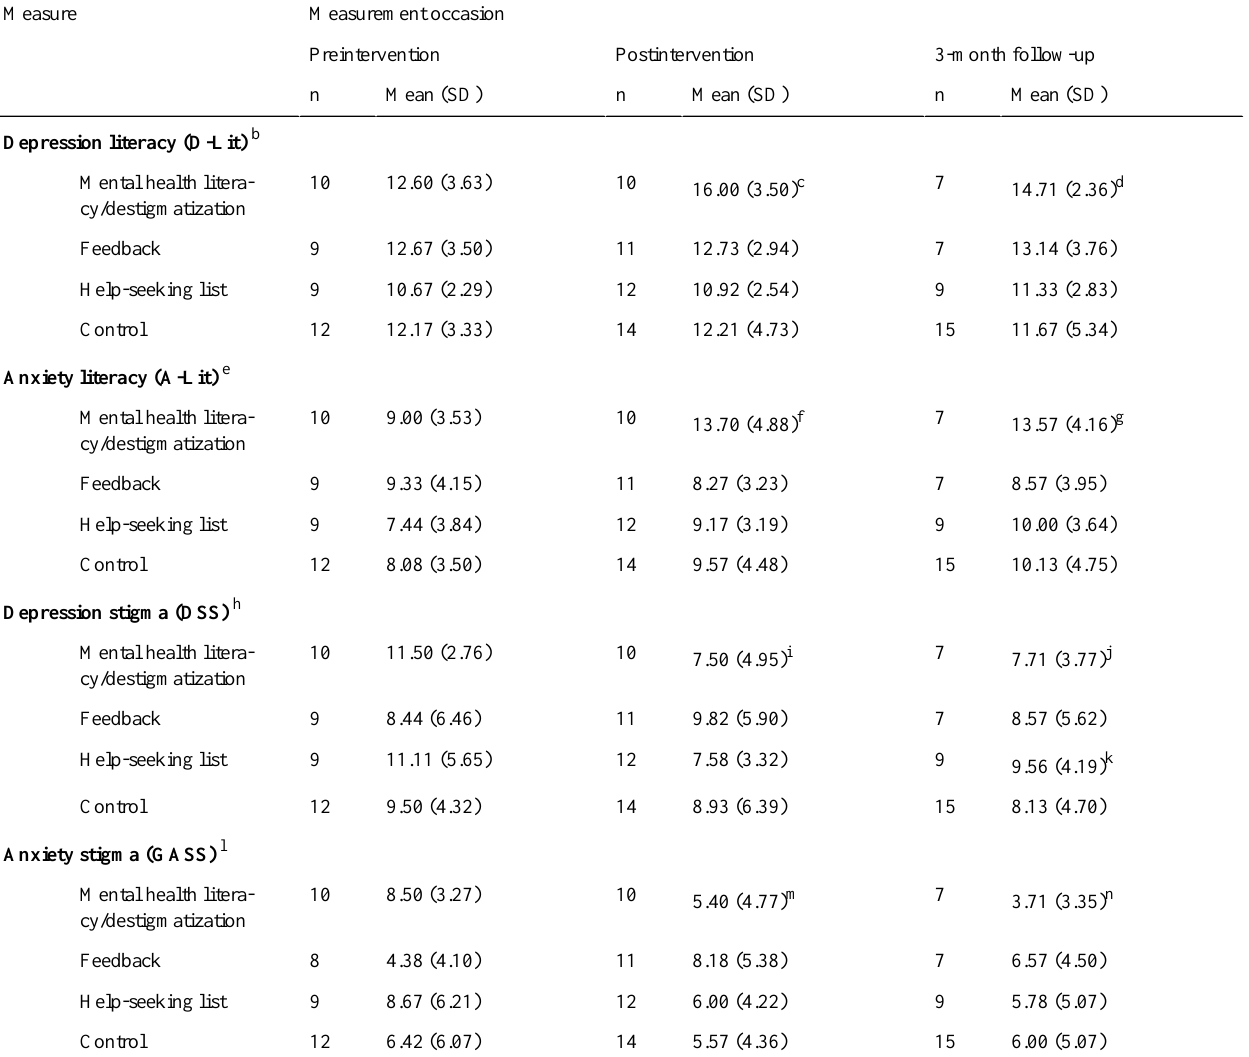
Table 4. Observed means and standard deviations for the secondary outcome measures at pre- and postintervention for the trial conditions.